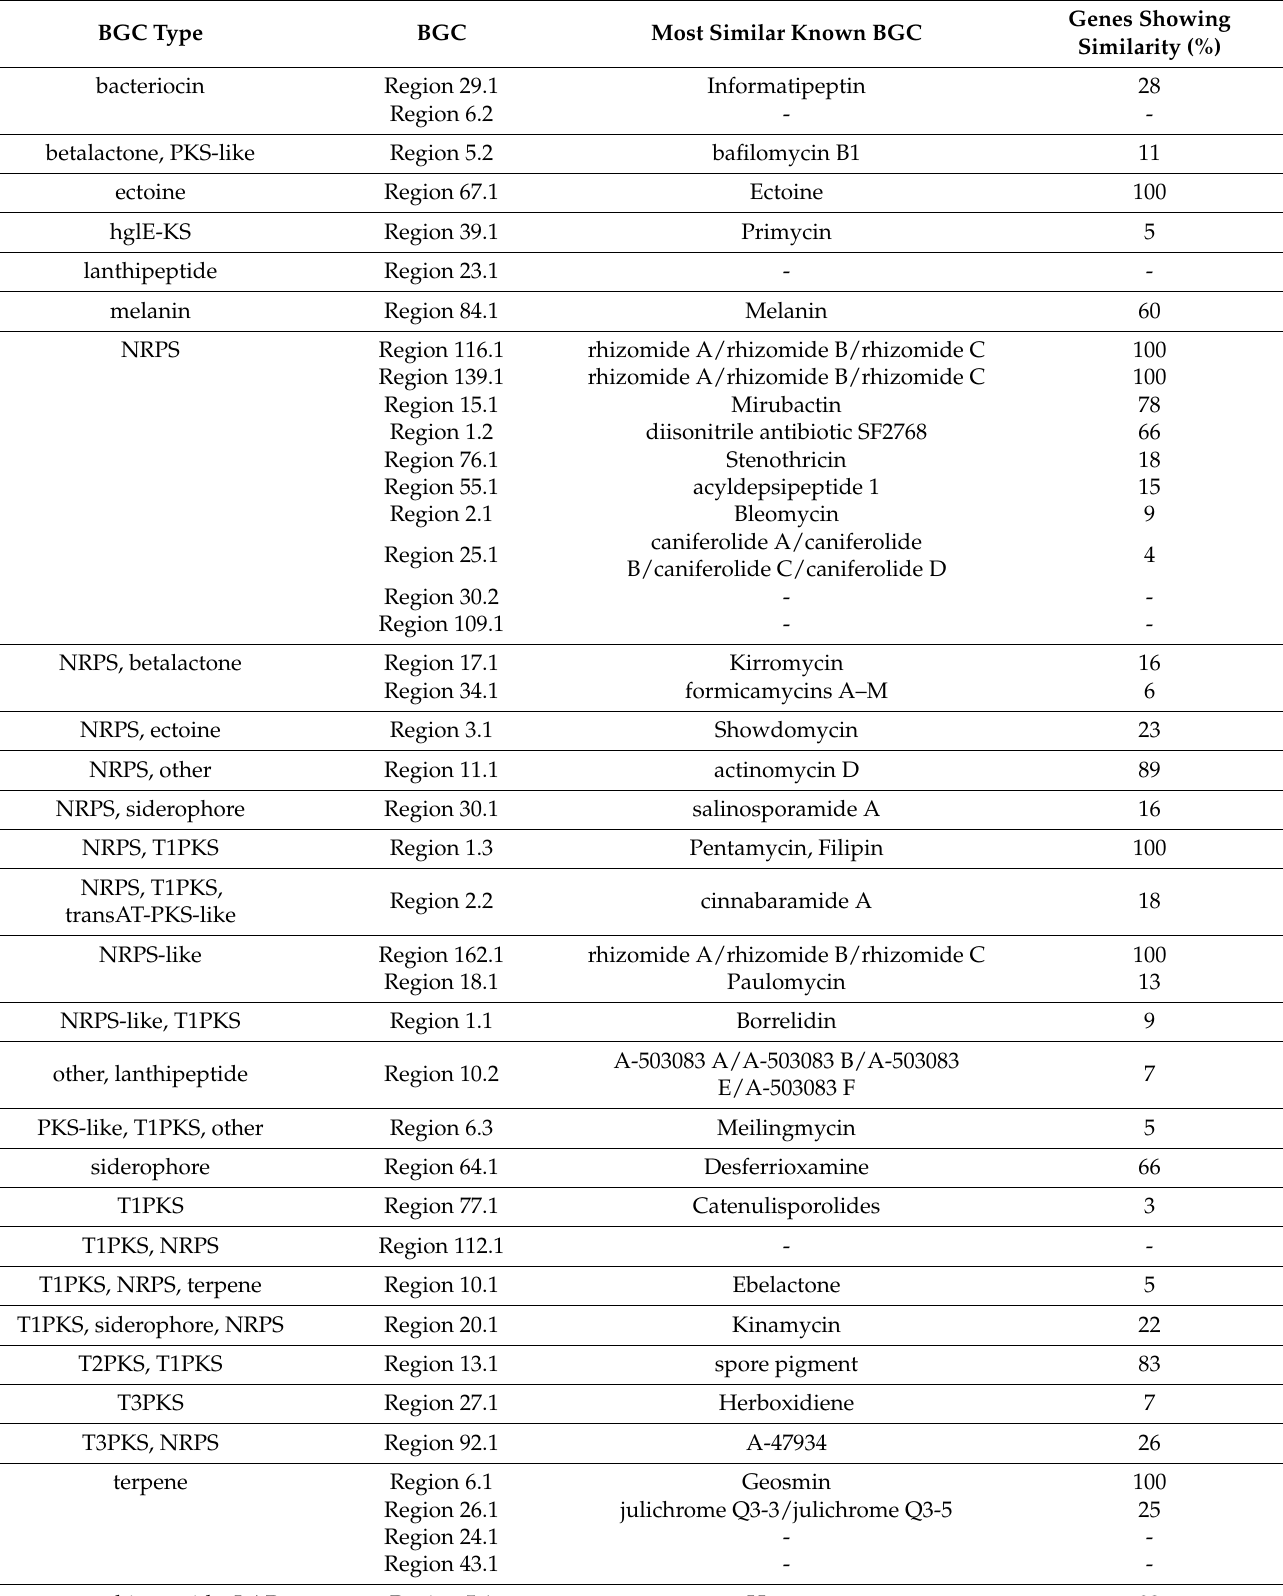
Table 2. Biosynthetic gene clusters (BGCs) predicted in Streptomyces sp. TR1341 using antiSMASH